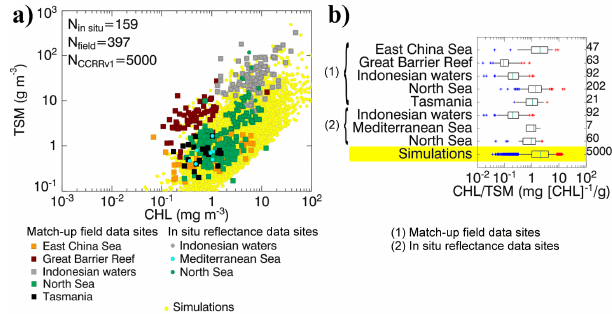
Figure 10. The distribution of (a) CHL concentrations (mgm − 3 ) vs. TSM concentrations (gm − 3 ) from the in situ reflectance data set (in the three sites as indicated in the key) plotted as filled cir- cles, and from the match-up data set, including Chl a and TChl a (where available), and the associated match-up field TSM concen- trations (in the six sites indicated in the key) and plotted as filled squares, both superimposed on the simulated data (yellow circles). (b) CHL / TSM ratio (mg[CHL] − 1 g − 1 ) from the match-up, in situ reflectance and simulated data sets. The graphical convention in panel (b) is identical to Fig. 6; the yellow colour distinguishes the simulated data set from the in situ